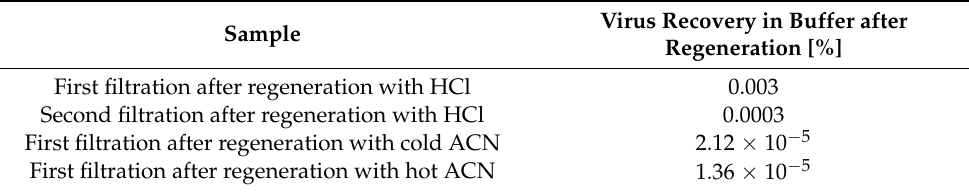
Table 6. Membrane regeneration studies.